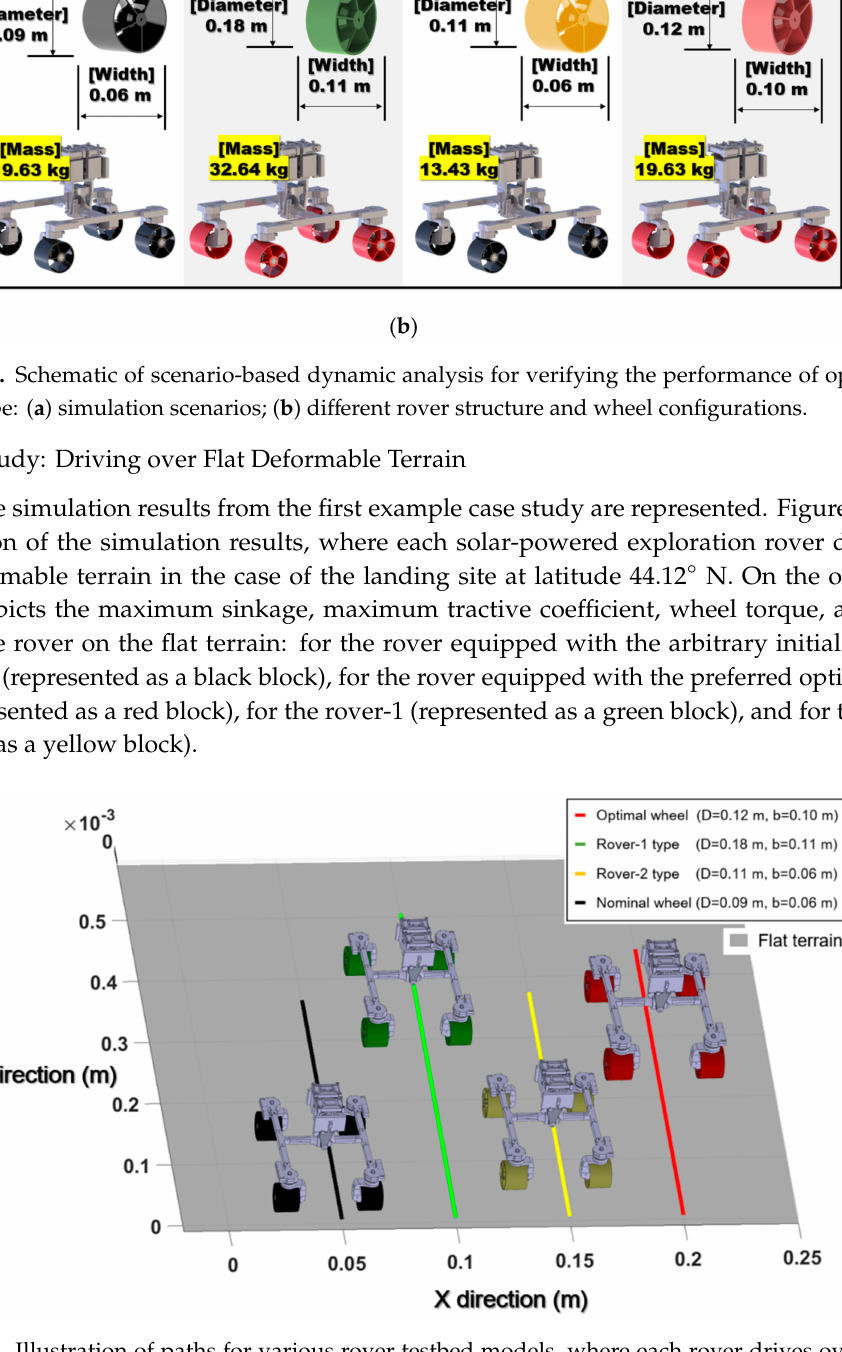
Figure 14. Illustration of paths for various rover testbed models, where each rover drives over flat deformable terrain in the case of landing site at 44.12 ◦